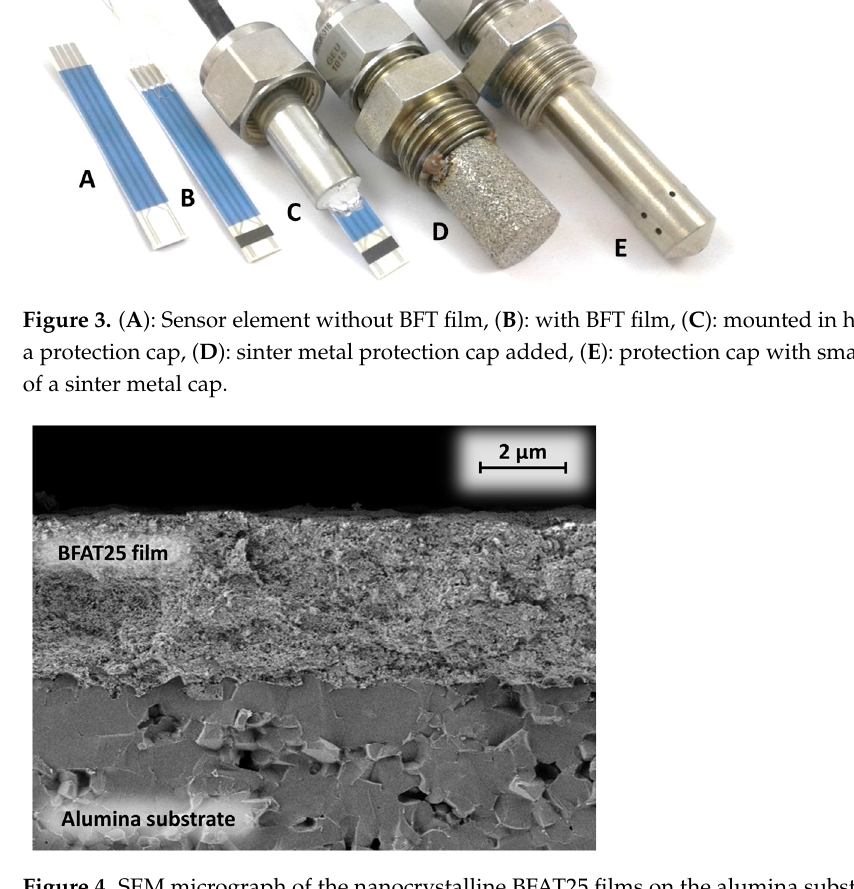
Figure 3. ( A ): Sensor element without BFT fi lm, ( B ): with BFT fi lm, ( C ): mounted in housing without a protection cap, ( D ): sinter metal protection cap added, ( E ): protection cap with small holes instead of a sinter metal cap.